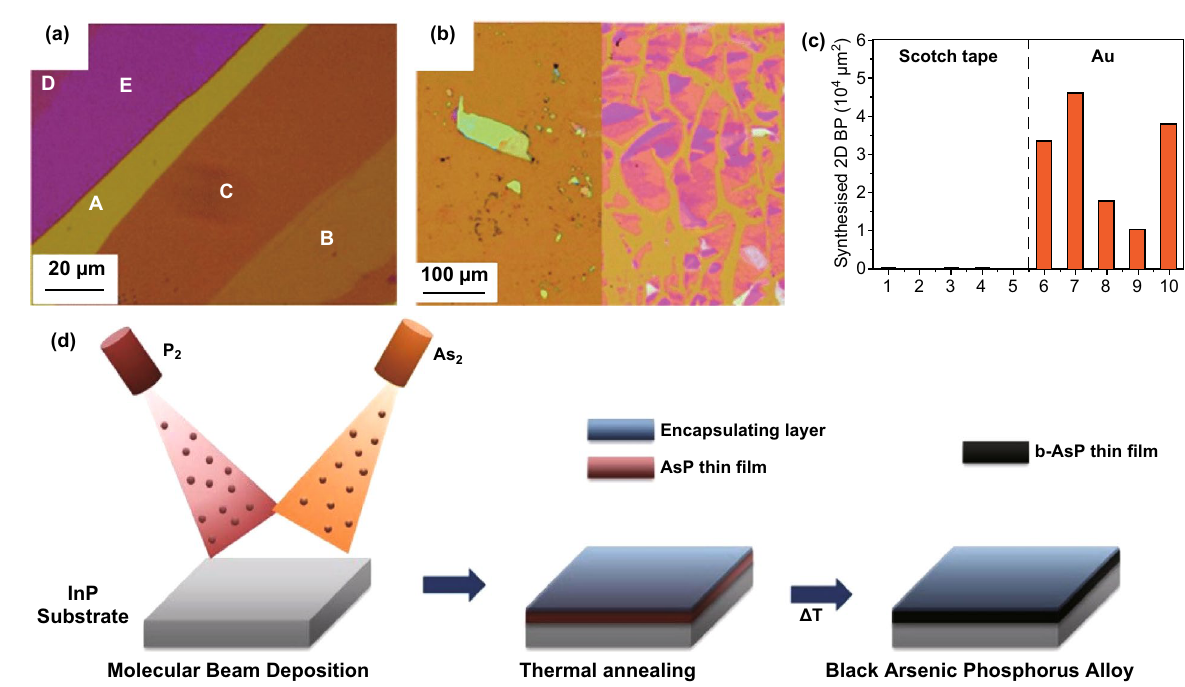
Fig. 6 Large-area synthesis of phosphorous compounds. a Optical microscope images of few layer black phosphorus (FLBPs) exfoliated via the Ag- assisted methods, b the left is FLBPs exfoliated using the normal “scotch-tape” method and the right is BP exfoliated using the Au-assisted method, and c the total area of FLBP on 10 different samples. Adapted with permission from Ref. [21]. Copyright 2018, Royal Society of Chem- istry Publishing Group. d Schematic of wafer-scale MBE grown 2D b-AsP achieved by evaporation of P 2 and As 2 followed by thermal anneal- ing. Adapted with permission from the Ref. [22]. Copyright 2018 American Chemical